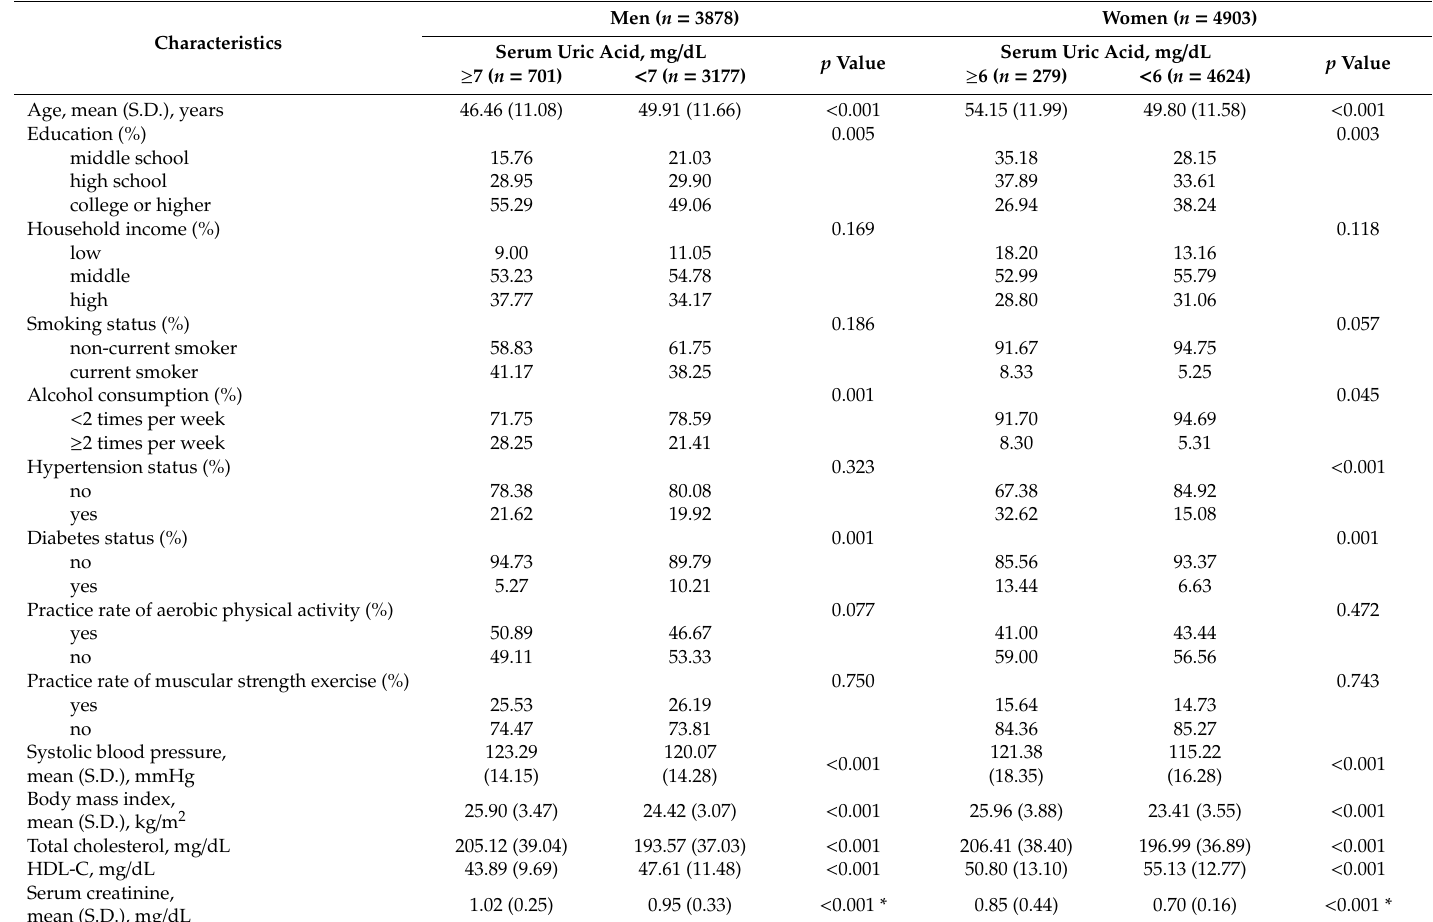
Table 1. General characteristics of the study